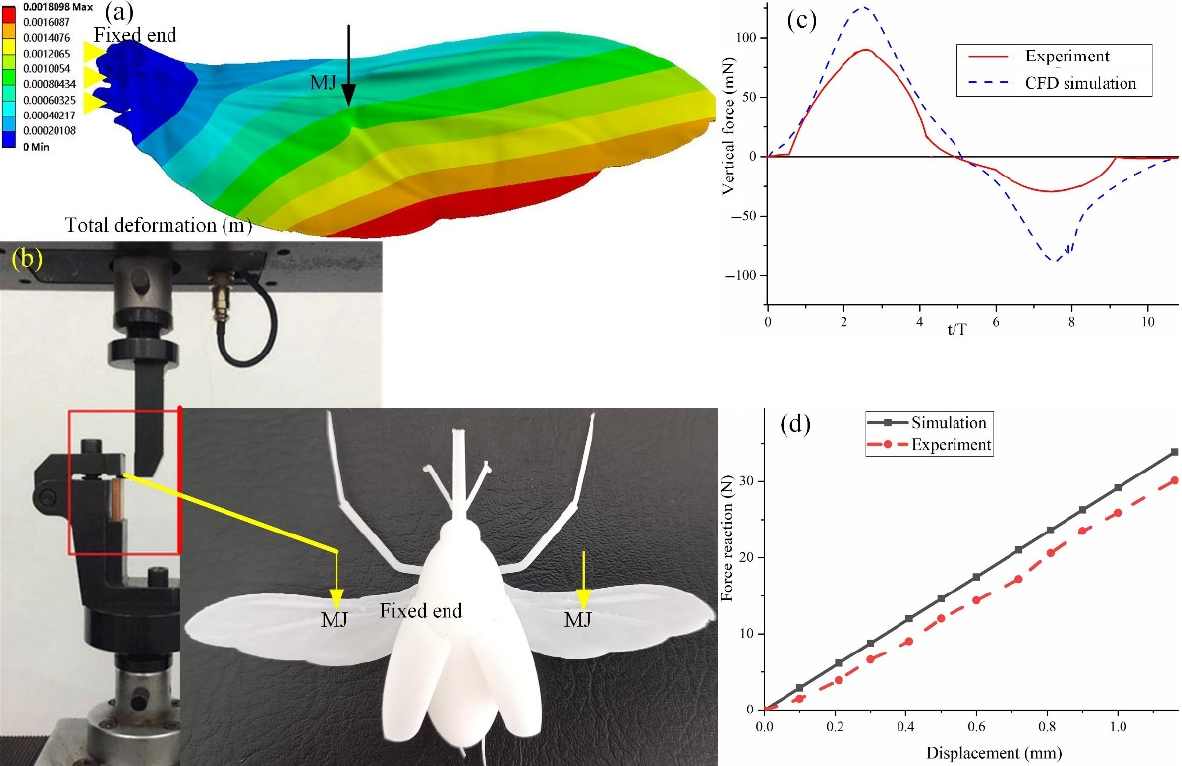
Figure 10. Comparison of simulation results with experimental results. ( a ) Deformation simulation for a 1.2 mm displacement at point MJ. ( b ) Bending experiment for a 1.2 mm displacement at point MJ. ( c ) Comparison of CFD simulation and experimental results. ( d ) Comparison of results from finite element simulations and bending experiments.